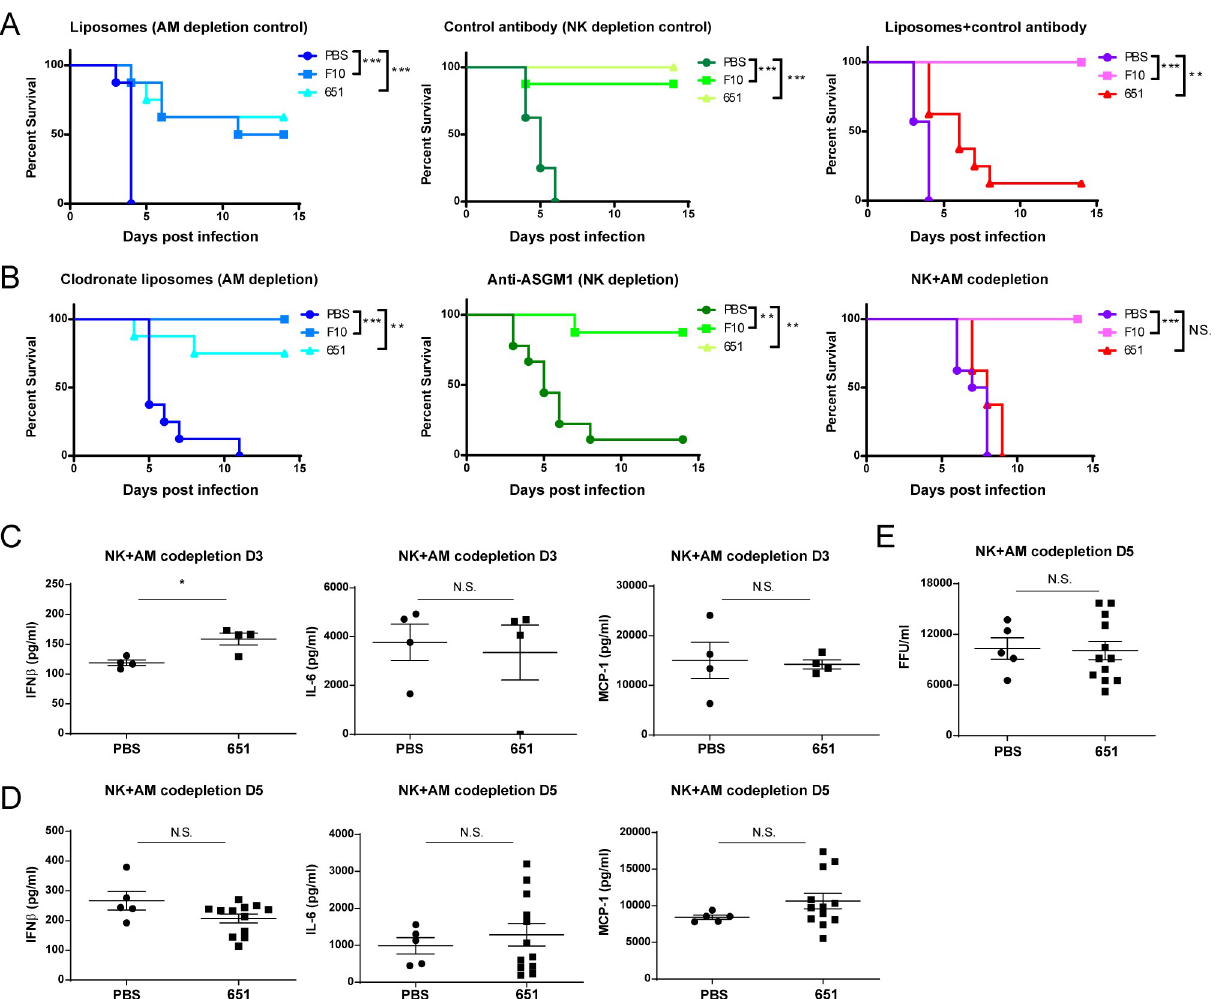
Fig 5. 651-mediated protection in mice requires both alveolar macrophages and NK cells. (A and B) Cumulative survival rate of mice receiving control reagents, including liposome alone, control antibody, or both (A), or clodronate liposomes or/and anti-ASGM1 antibody (B) prior to i.p. injection of mAbs and 100 LD50 Cal/09 intranasal challenge. n = 7–8 mice per group in A and 8–9 mice per group in B. (C and D) Comparison of pulmonary IFN β , MCP-1, and IL-6 protein levels measured by ELISA in alveolar macrophages (AM)-NK co-depleted mice treated with either PBS or 651 on day 3 (C) and day 5 (D) post-Cal/09 infection. n = 4 mice per group in C. n = 5 in PBS group and n = 12 in 651 group in D. (E) Fluorescent focus assay showing the comparable influenza virus titers in AM-NK co-depleted mice treated with either PBS or 651 on day 5 after Cal/09 infection. n = 5 in PBS group and n = 12 in 651 group in E. Data in A and B were analyzed by log-rank (Mantel-Cox) test. Data in C-E are mean ± SEM. � p < 0.05; �� p < 0.01; ��� p < 0.001. N.S. = no significant